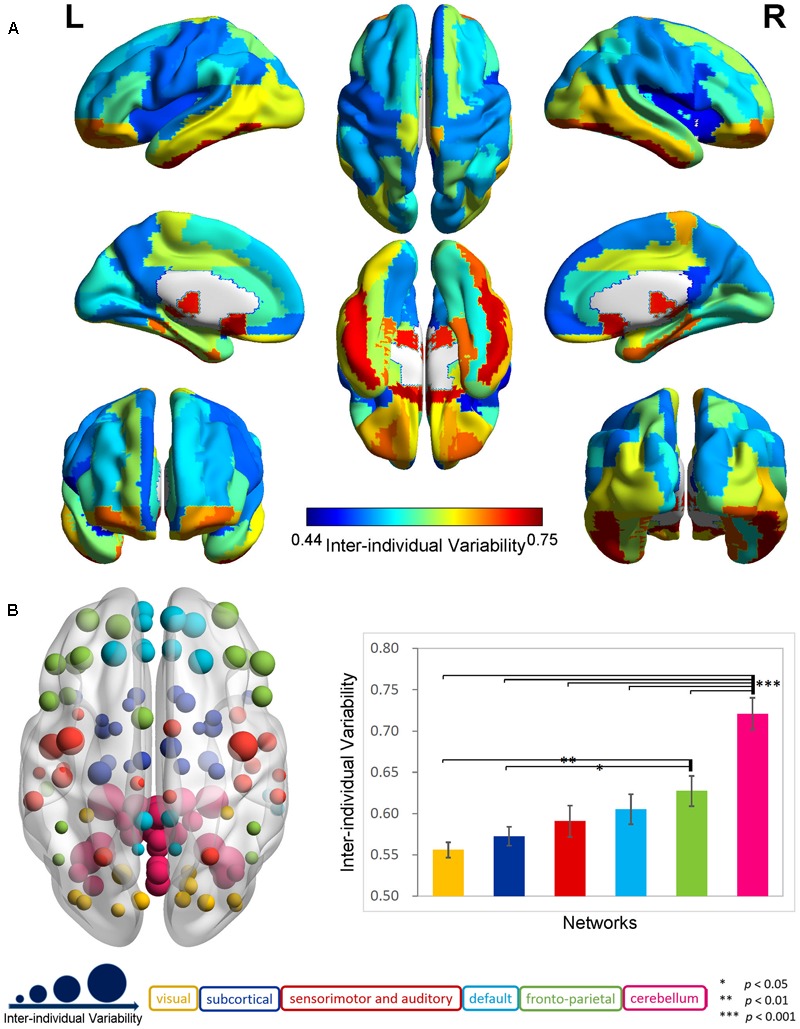
Inter-individual difference in functional brain connectivity in elderly individuals. (A) Distribution of inter-individual functional variability in the cerebrum. The inter-individual variability values for the 90-automated anatomical labeling (AAL) cerebral regions were mapped onto the cortical surfaces using varied colors. (B) Inter-individual variability in functional networks. The left axial map shows the inter-individual variability in the functional connectivity for 116 AAL regions, which are rendered as color-coded nodes, according to the functional networks (He et al., 2009). The nodes are located at the center of these regions, and the nodal size is proportional to the level of the inter-individual variability. The right histogram plots the averaged inter-individual variability values and the standard errors for the functional networks, which are displayed as color-coded bars in the corresponding color applied to the nodes.